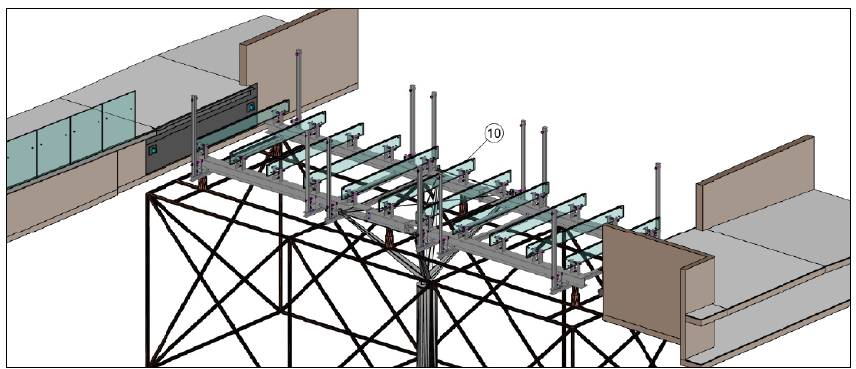
Figure 4: Installation Sequence 10) Installation and adjustment of all glass floor beams